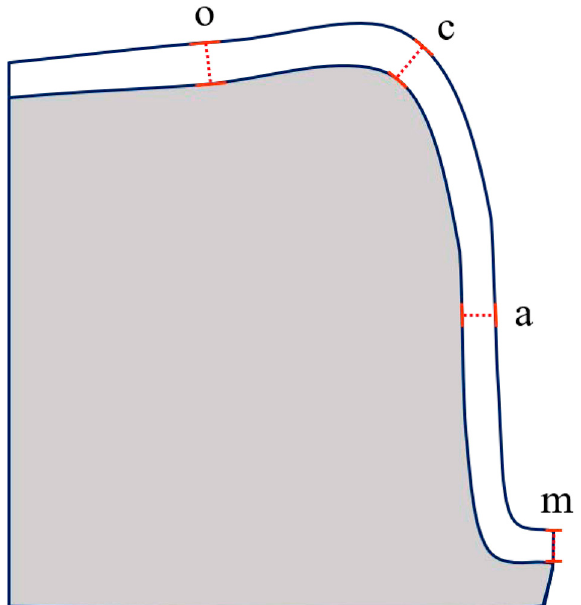
Figure 5. Schematic diagram of the points measured on each cross-section, o, occlusal gap (midpoint of occlusal wall); c, gap of cusp tip (axio-occlusal transition point); a, axial gap (midpoint of axial wall); m, marginal gap.